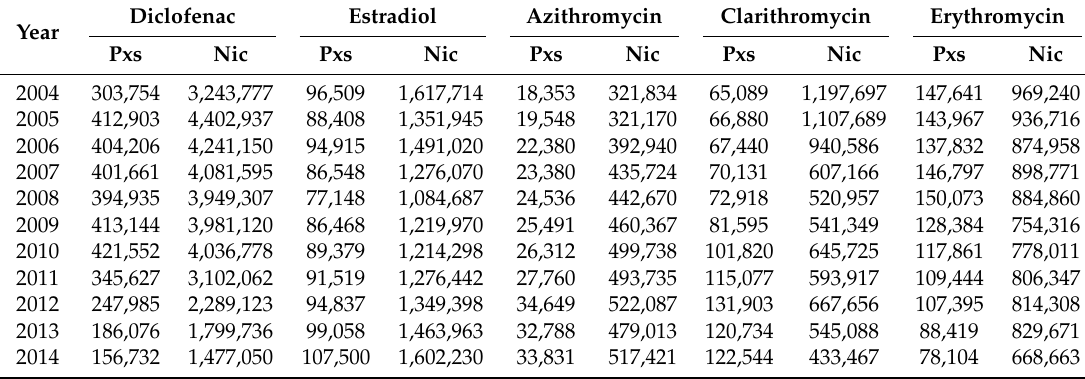
Table B4. Total Prescriptions Items and Total Cost per each Examined Substance from 2004 to 2014 in Northern